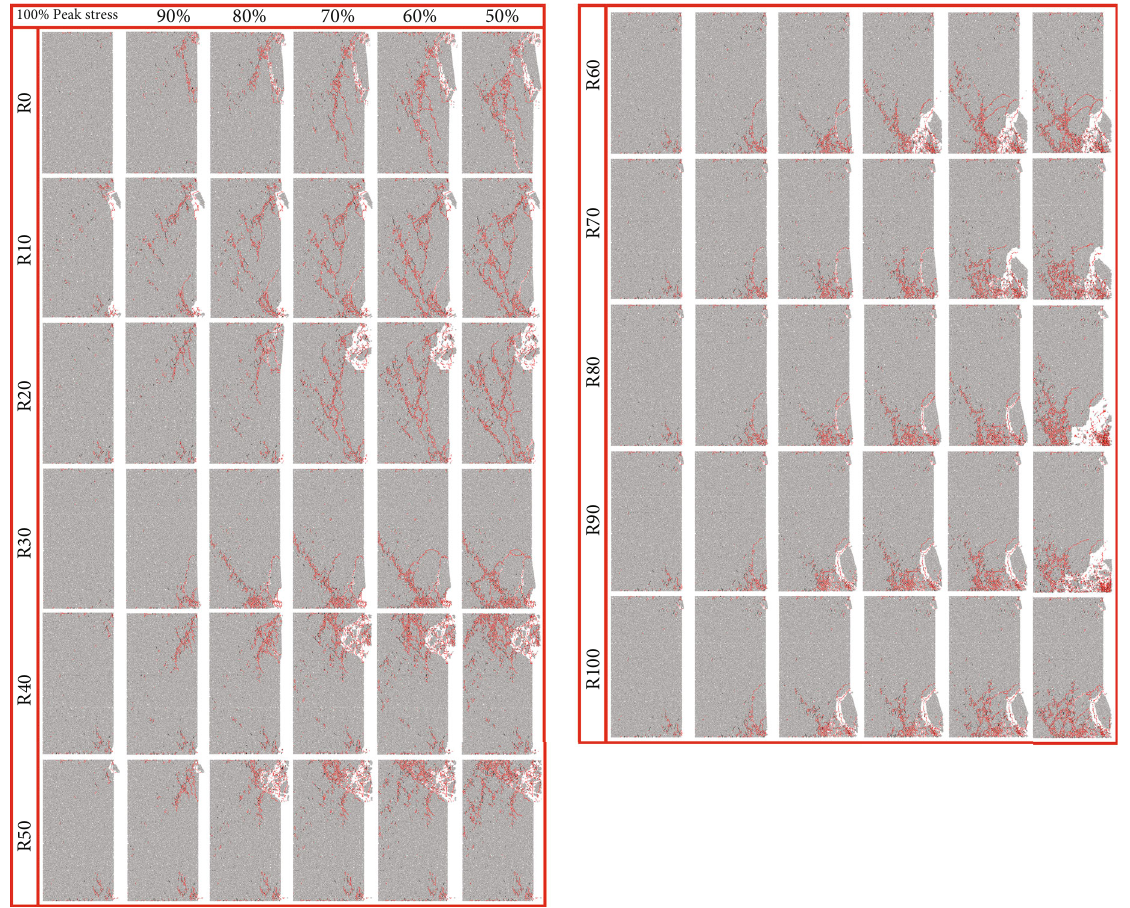
Figure 19: Crack evolution behavior corresponding to di ff erent CRVs.